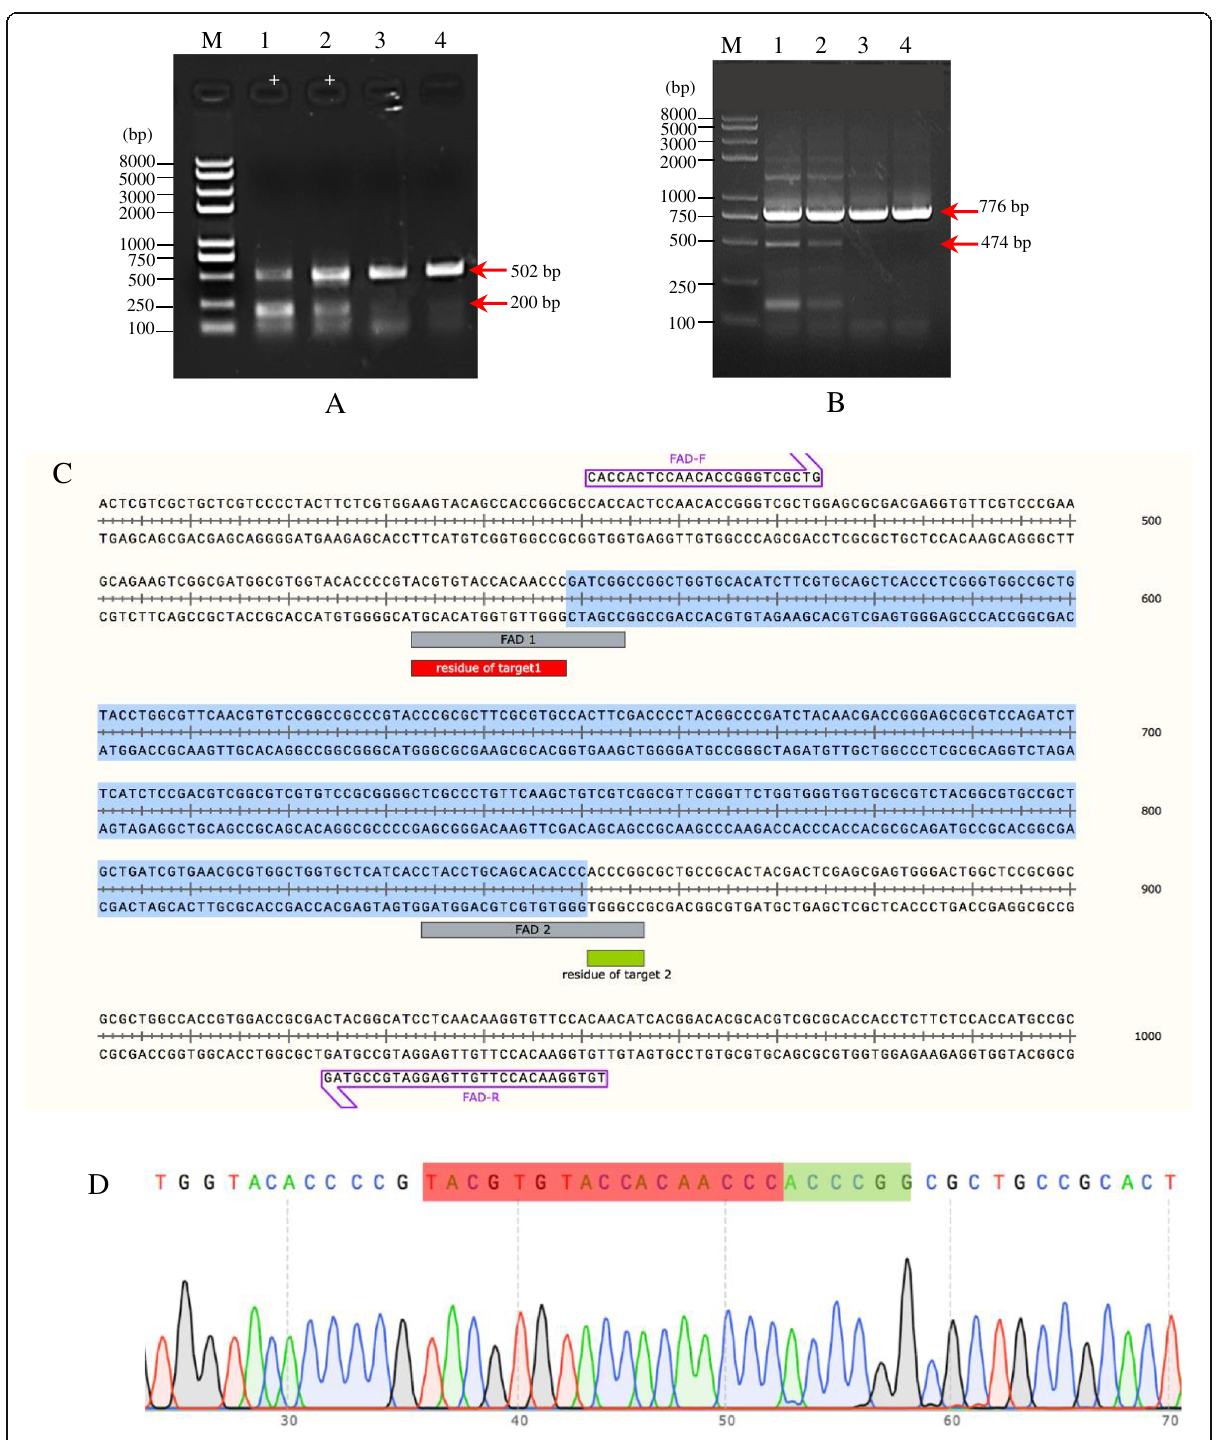
Fig. 4 PCR-amplified DNA from protoplasts transfected with pYLCRISPRCas9Pubi-H:OsFAD2. A DNA fragments of 502 bp and 200 bp were amplified using FAD2-F and FAD2-R primers. B DNA fragments of 776 bp and 474 bp were amplified from second set PCR using FAD2-F2 and FAD2-R primers. Lane M is Trans2K® Plus II DNA Marker (TransGen Biotech, China), and lanes marked with “ + ” are positive samples. C PCR products at 474 bp were directly sequenced and analysed using SNAPGENE revealed mutations consisting of deletions in the DNA region between sgRNA1and sgRNA2. The blue background part is the deleted sequences; the first line (sequence of the wild type target gene) and target site in grey boxes were highlighted. D Sequencing chromatogram, the red box is the residue of target 1 (OsFAD2-T1), and the green box is the residue of target 2